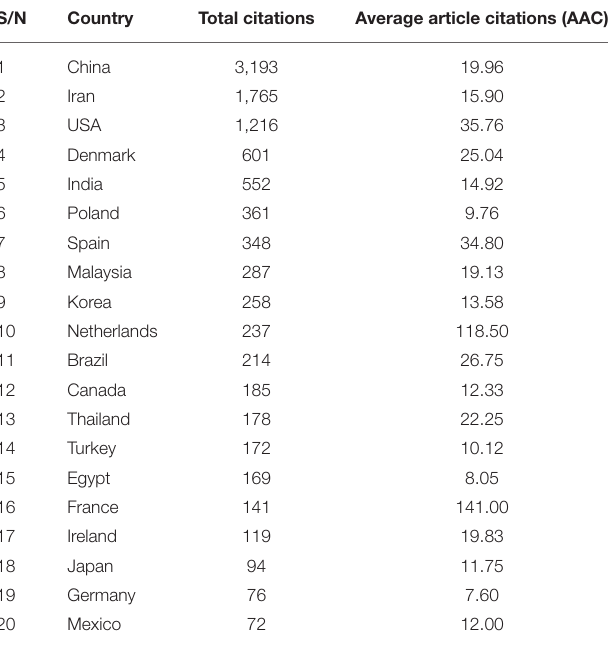
TABLE 2 | The top 20 most cited countries in terms of average article citations (AAC) in the field of meat production and nanotechnology from 1985 to